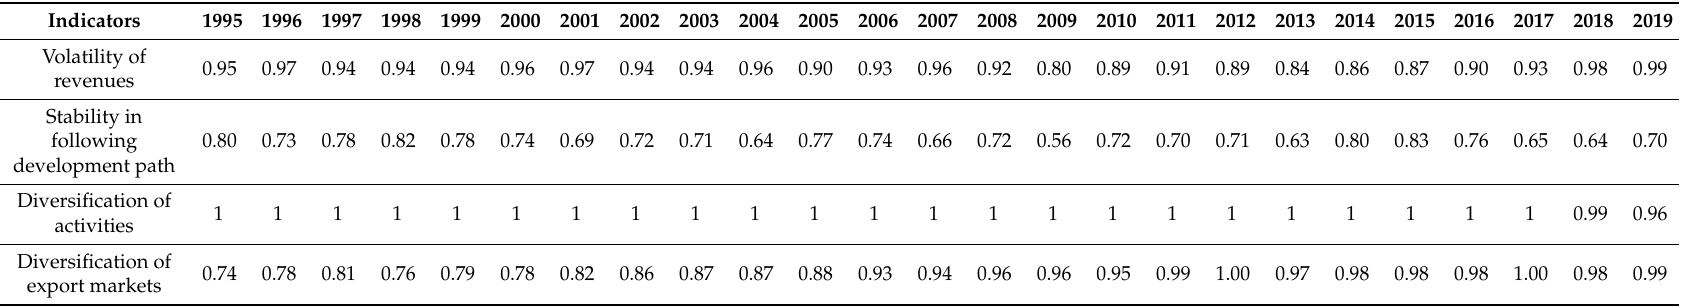
Table 3. Indicators used for computing economic resilience